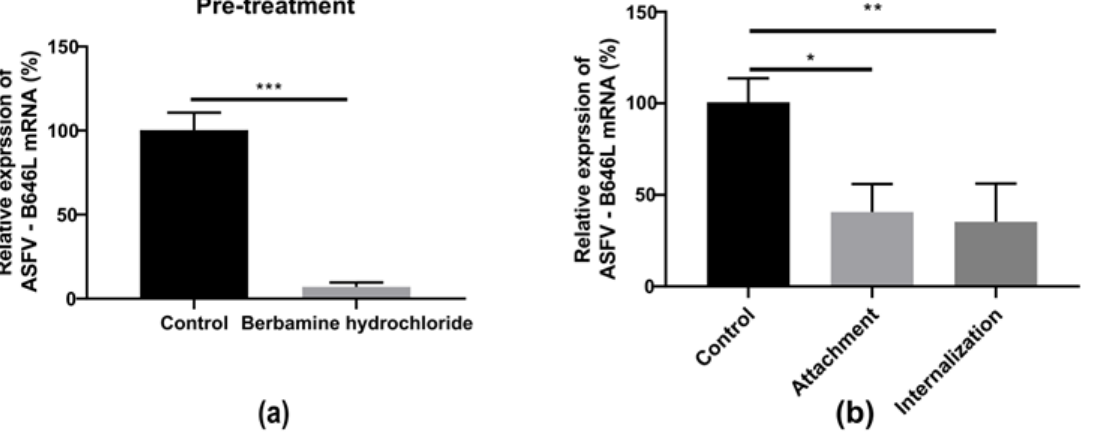
Figure 6. The effect of berbamine hydrochloride on the ASFV’s early stage. ( a ) The PAMs were pre-treated with berbamine hydrochloride for 4 h and then infected with the ASFV for 24 h; the ASFV B646L transcription level was evaluated with an RT-qPCR. ( b ) Attachment: the PAMs were infected with a mixture of the ASFV and berbamine hydrochloride at 4 °C for 1.5 h and incubated at 37 °C for another 24 h in the absence of drugs; internalization: PAMs were infected with the ASFV at 4 °C for 1.5 h and then treated with berbamine hydrochloride at 37 °C for 1 h, then the drug was discarded, and the solution was incubated at 37 °C for another 24 h in the absence of the drug. The ASFV B646L transcription level was evaluated with an RT-qPCR. Each datum represents the results of three independent experiments (means ± SD). Significant differences compared with the control group are denoted with *, p < 0.05; **, p < 0.01; ***, p < 0.001.